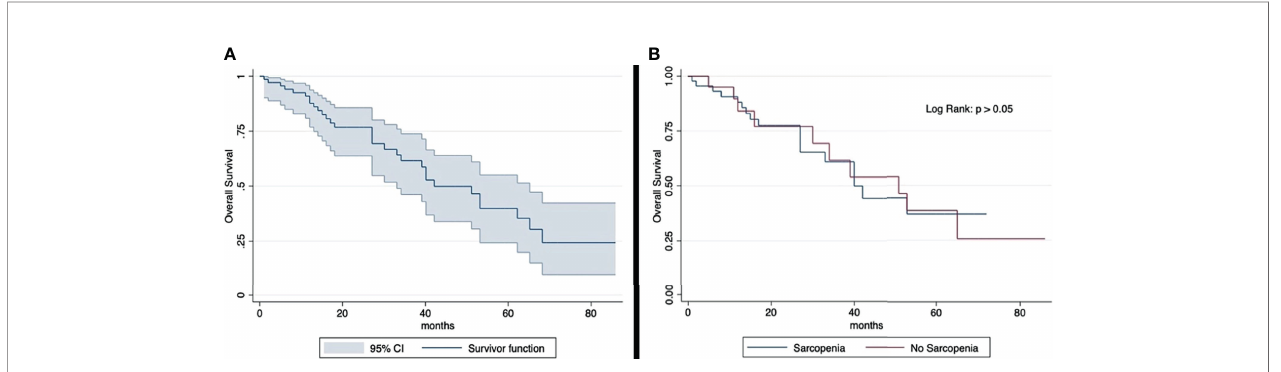
FIGURE 2 | Kaplan-Meier curve showing overall survival for total sample (A) and by sarcopenia (B) . Median OS: 23 months (IQR: 29 months). 2-year OS rate: 77% (sarcopenic: 77%; non-sarcopenic: 78%); 5-year OS rate: 40% (sarcopenic: 39%; non-sarcopenic: 37%). The overall survival shows an overlap in the two groups divided according to